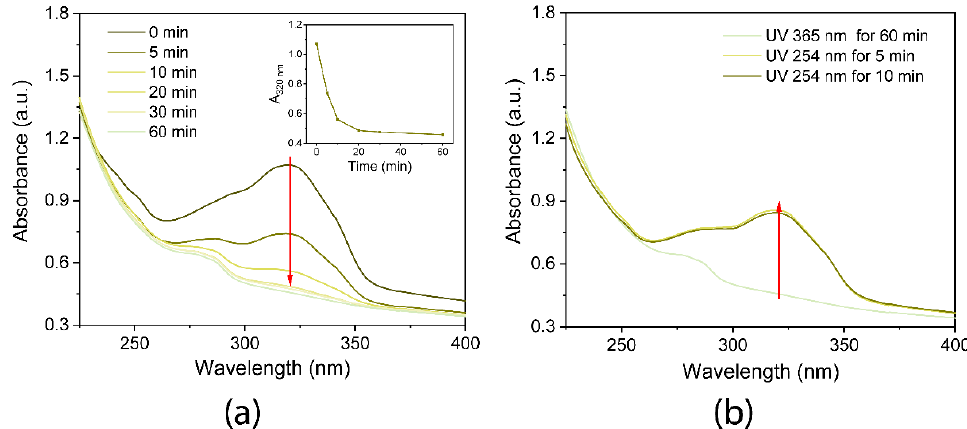
Figure 3. Time-dependent UV-Vis absorption spectra of 10 mg/mL OEG bis-urea amphiphile solution containing 10% Cou-crosslinker under UV light: ( a ) UV light 365 nm (Insert: absorbance changes at 320 nm recorded as a function of irradiation time) and ( b ) UV light 254 nm. The red arrows indicate change in absorbance change with time.